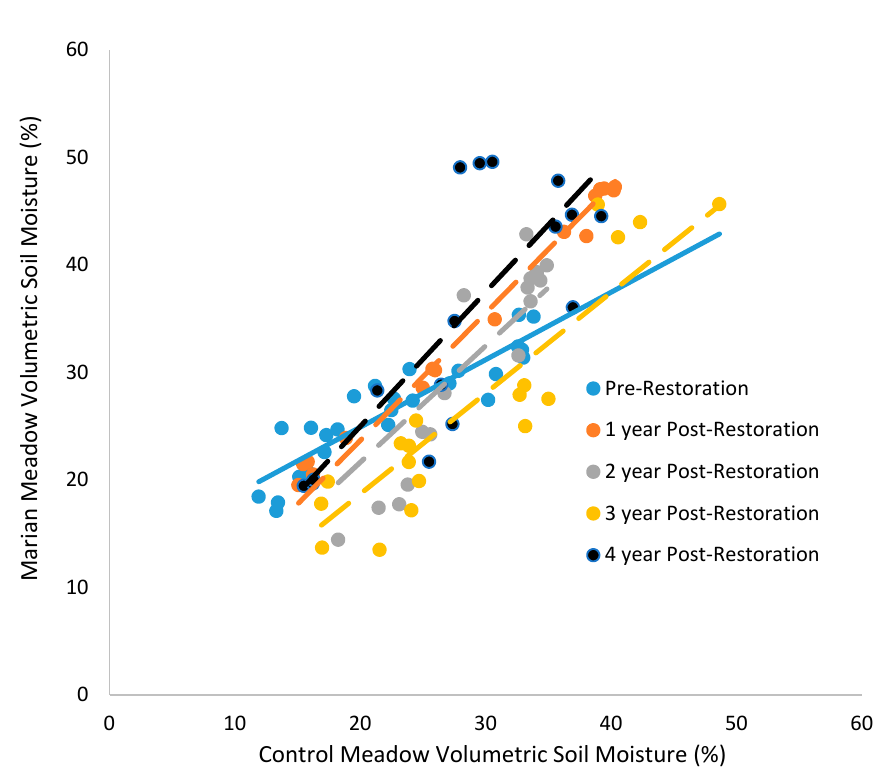
Figure 4. Pre-restoration and post-restoration scatter plots and regression lines between Marian Meadow and Control Meadow soil moisture (%). Solid line indicates pre-restoration relationship while the dashed lines indicate post-restoration relationships.